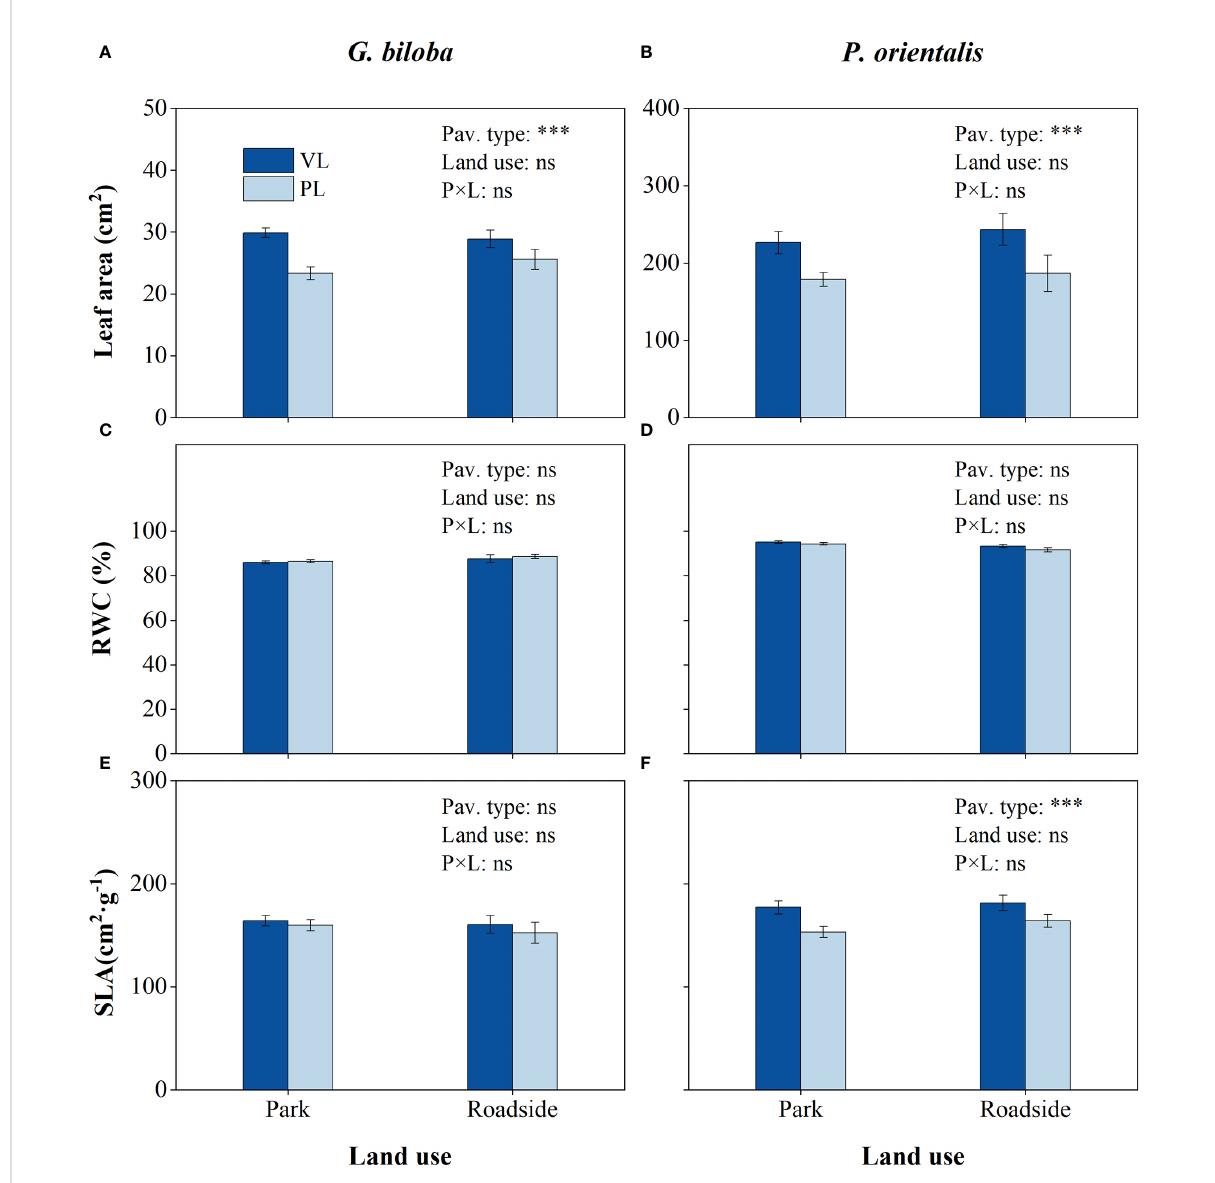
FIGURE 5 Results from the linear mixed-effects model (LMM) testing for the differences in leaf area (A, B) , relative water content (RWC) (C,D) , and speci fi c leaf area (SLA) (E, F) vs. the pavement type (VL, vegetated land; PL, paved land), land use (park and roadside), and their interactions. ***, P < 0.001; ns, not signi fi cant. Data represent mean ±